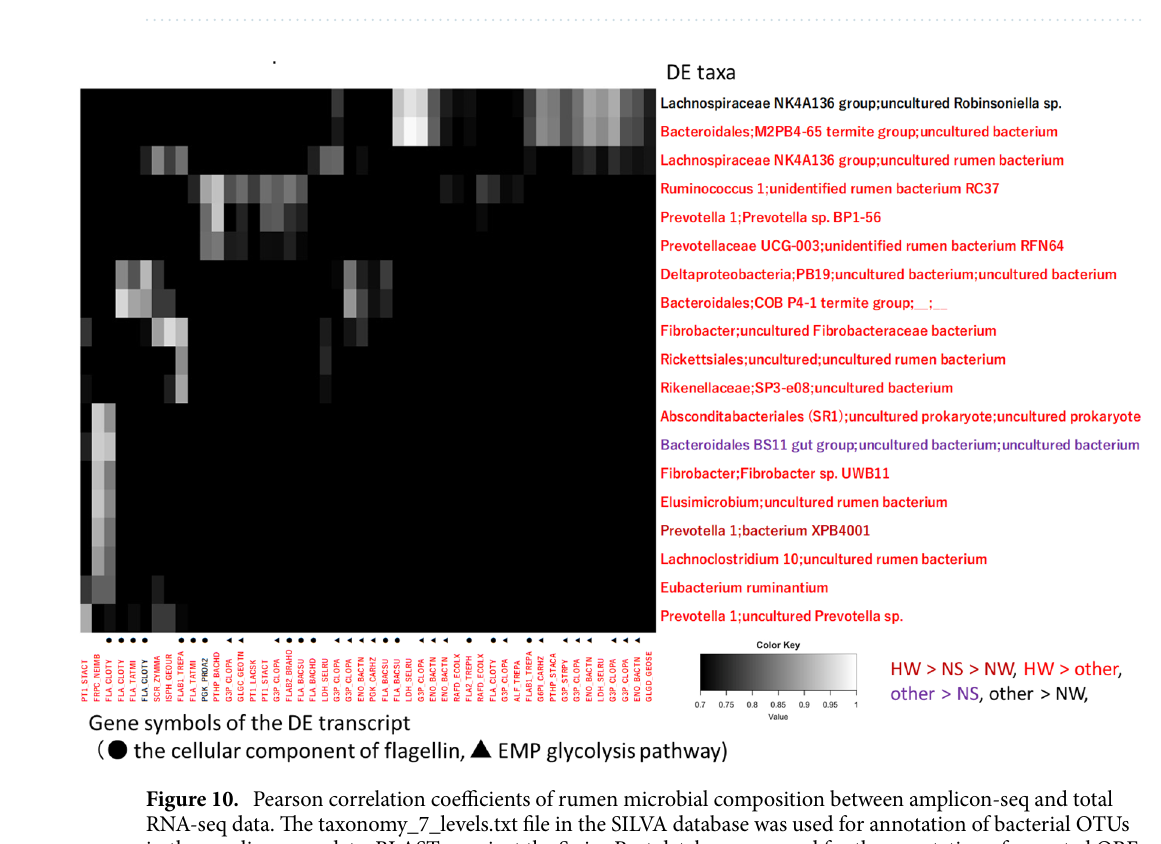
Figure 10. Pearson correlation coefficients of rumen microbial composition between amplicon-seq and total RNA-seq data. The taxonomy_7_levels.txt file in the SILVA database was used for annotation of bacterial OTUs in the amplicon-seq data. BLAST + against the Swiss-Prot database was used for the annotation of expected ORF sequences in the total RNA-seq data. Correlations with coefficients between 0.7 and 1.0 are shown. The color of the taxa with differential expression and gene symbols indicate statistically significant differences among the groups (q < 0.01) analyzed by TCC baySeq. The flagellin cellular component and EMP glycolysis pathway are shown as filled circles and triangles,